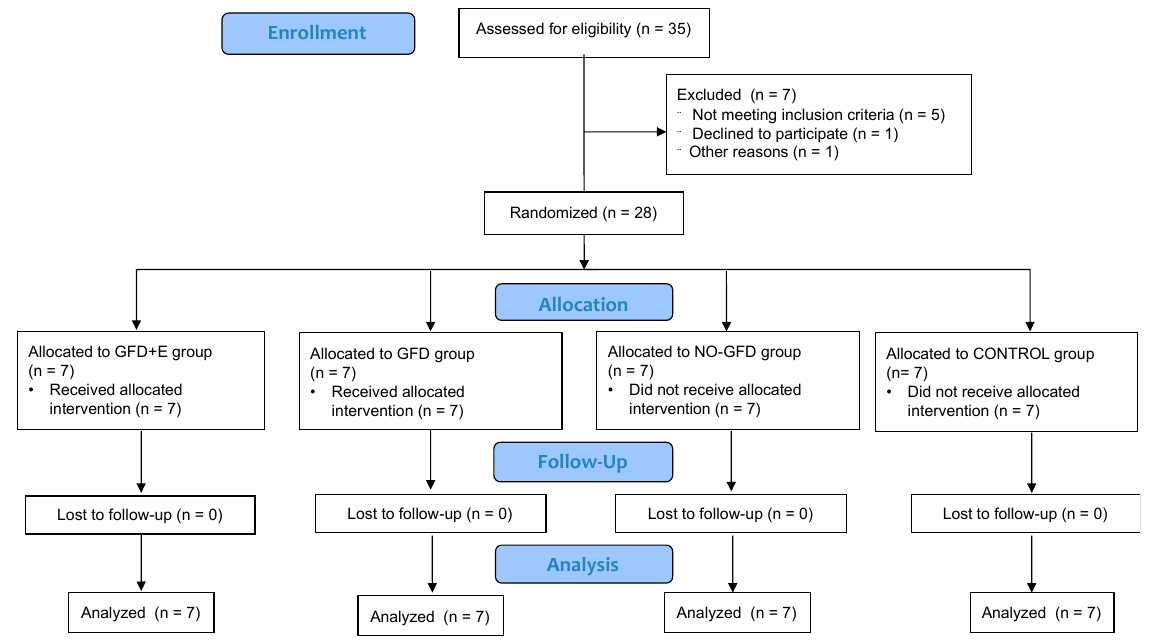
Figure 1. Consort 2021 flow diagram. Sample distribution.